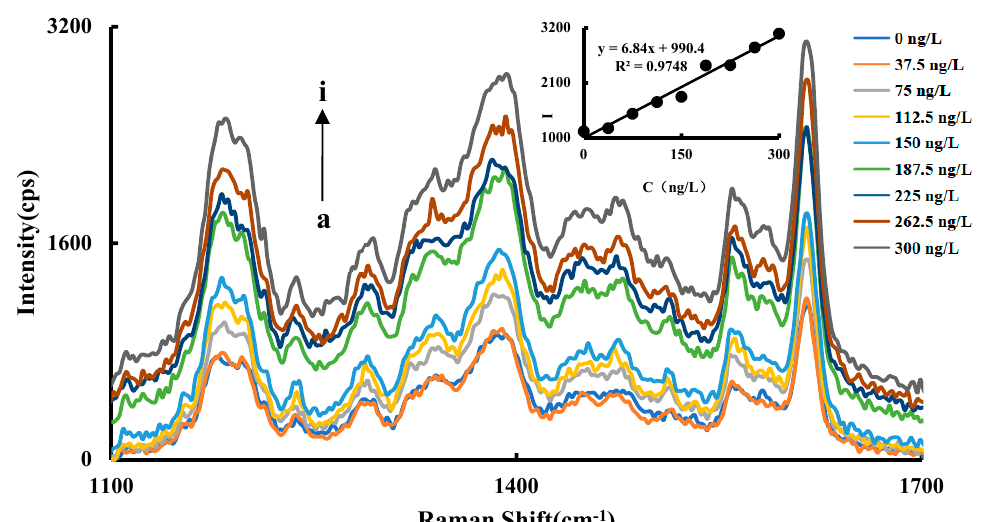
Figure 5. SERS spectra of the OTC analysis system a: 1.2 nmol/L CuNCs + 27.5 nmol/L Apt + 2.52 µ mol/L HAuCl4 + 1.87 mol/L ethanol + 0.65 mol/L HCl; b: a + 37.5 ng/L OTC; c: a + 75 ng/L OTC; d: a + 112.5 ng/L OTC; e: a + 150 ng/L OTC; f: a + 187.5 ng/L OTC; g: a + 225 ng/L OTC; h: a + 262.5 ng/L OTC; i: a + 300 ng/L OTC.